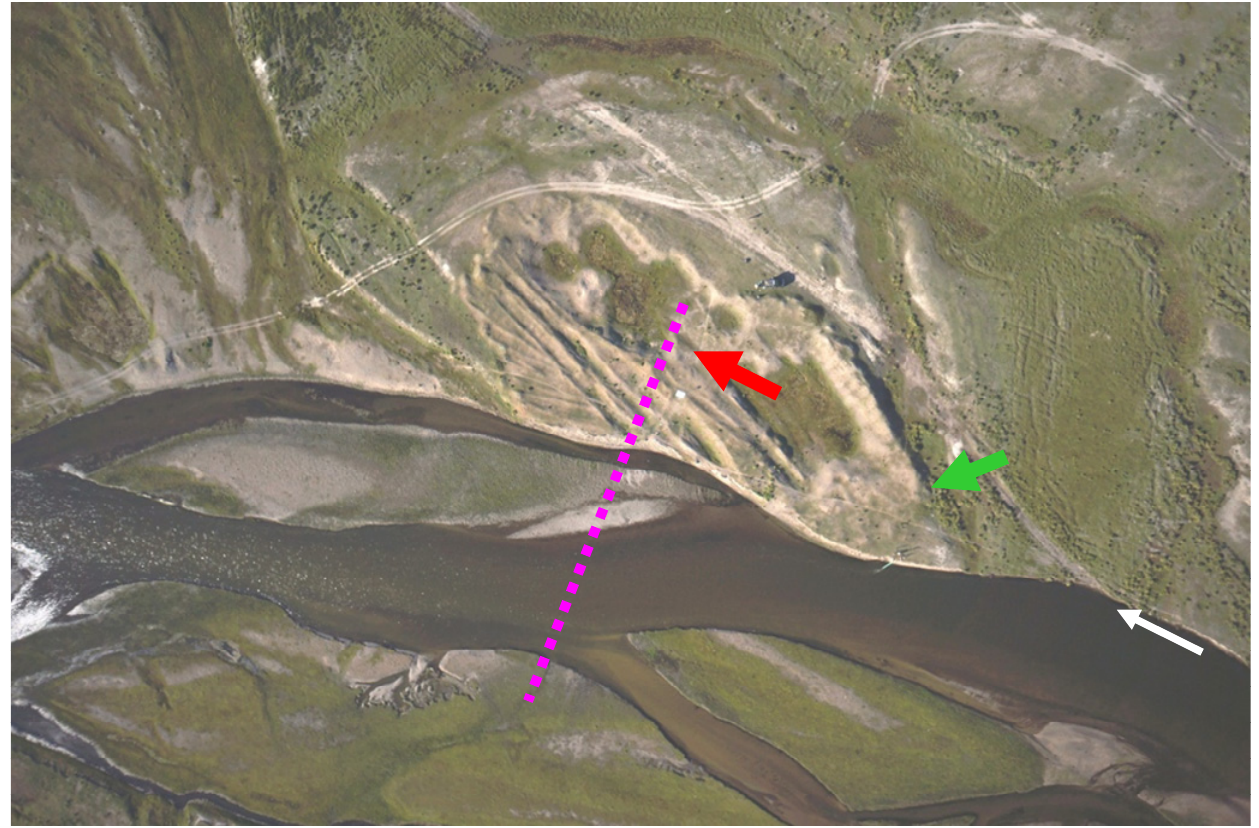
Figure 3. Vertical view from an unmanned aerial vehicle (octocopter) on the monitoring location at Baruunkharaa in the middle reaches of the Kharaa River. The cross profile (pink dotted line) of the official gauge (red arrow) is altered due to the formation of a small river island. The MoMo monitoring logger site (green arrow) is only 20 m upstream on a place with strong river bank erosion (flow direction is marked with a white arrow). Location: 48°54 ′ 42 ″ N, 106°4 ′ 30 ″ E, 796 m a.s.l., flight elevation 120 m above ground; the full panorama view is visible here